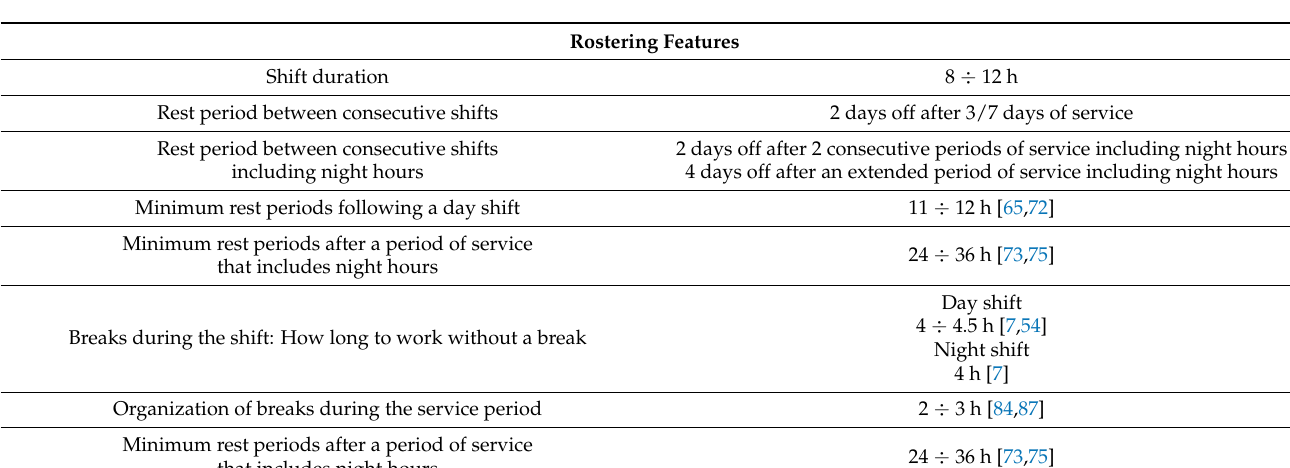
Table 3. Rostering features and reported